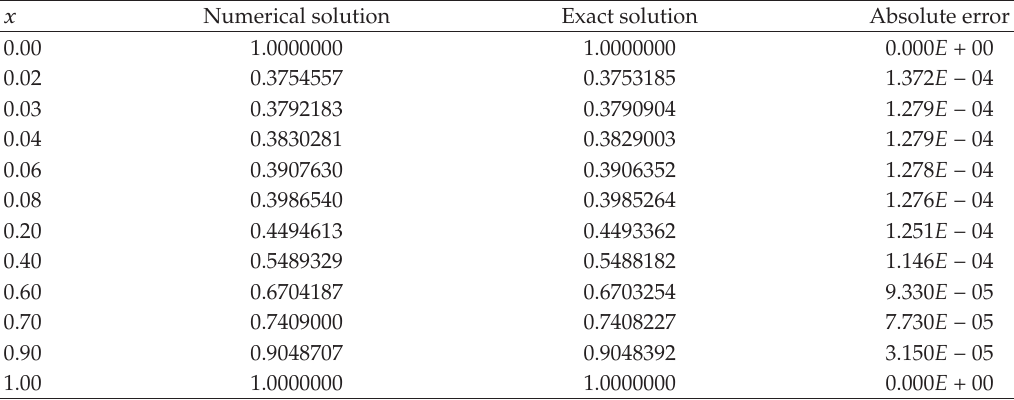
Table 4: Numerical results of Example 4.1 for ε (cid:8) 0 . 0001 , δ (cid:8) 0 . 00008, N (cid:8) 100.